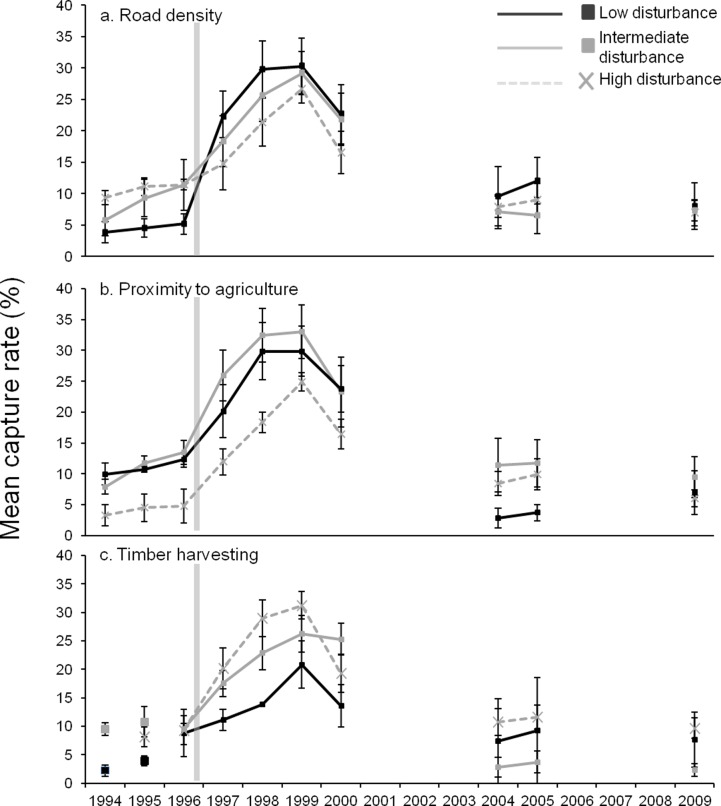
Mean capture rate of grid sites over time grouped by level of disturbance.a) Road density. Low: <1500 m, n = 6. Intermediate: 1600–2400 m, n = 6. High: >2400 m, n = 6. b) Proximity to agriculture. Low: >900 m, n = 4. Intermediate: 400–810 m, n = 6. High: <300 m, n = 8. c) Time since timber harvest. Low: 44 yrs in 1994, n = 2; 45 yrs in 1995, n = 3; 46 yrs in 1996 onwards, n = 2. Intermediate: 21–24 yrs in 1994, n = 10; 25 yrs in 1995, n = 6; 26 yrs in 1996 onward, n = 5. High: harvested in 1995 or 1996, n = 9 in 1995 and n = 11 in 1996 onwards. Transparent grey vertical line indicates time of commencement of quarterly aerial fox baiting. In Fig 3C, site classification varied between 1994 and 1996 so 1994 and 1995 are represented by data points only. In 1994, there were no sites classified as highly disturbed by timber harvesting. Bars indicate standard error.